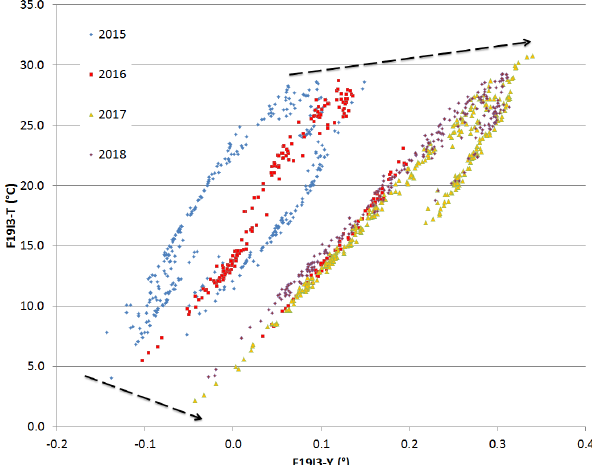
Figure 25. Progressive increase in tiltmeter F19I3-Y measurement values (see dashed arrows) from 2015 to 2018 for local